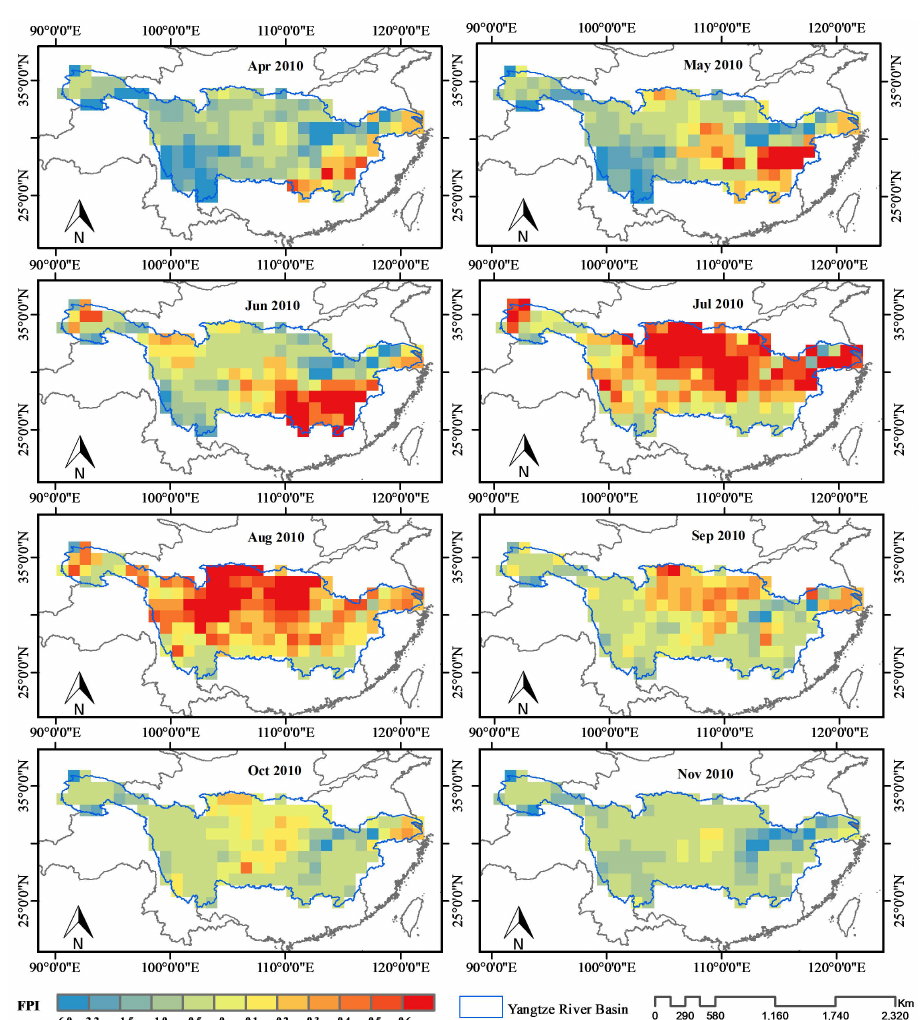
Figure 11. Spatial distribution of the flood potential index (FPI) for the Yangtze River Basin from April to November